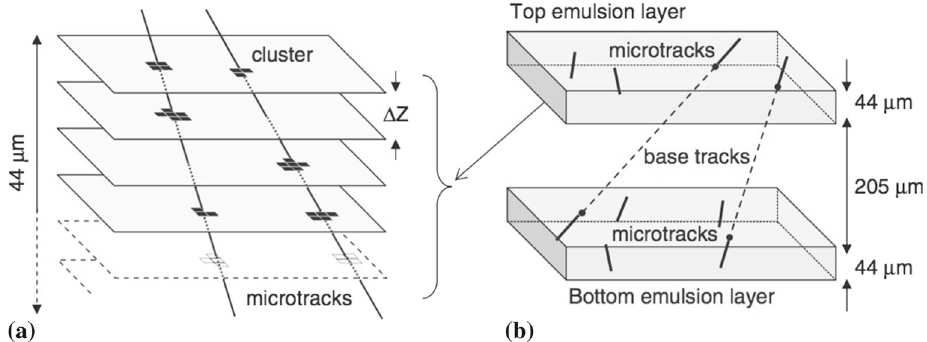
Fig. 1 a Combination of clusters belonging to images taken at different depths in one emulsion layer forms a micro-track; b the association of two micro-tracks across the plastic base forms a base-track